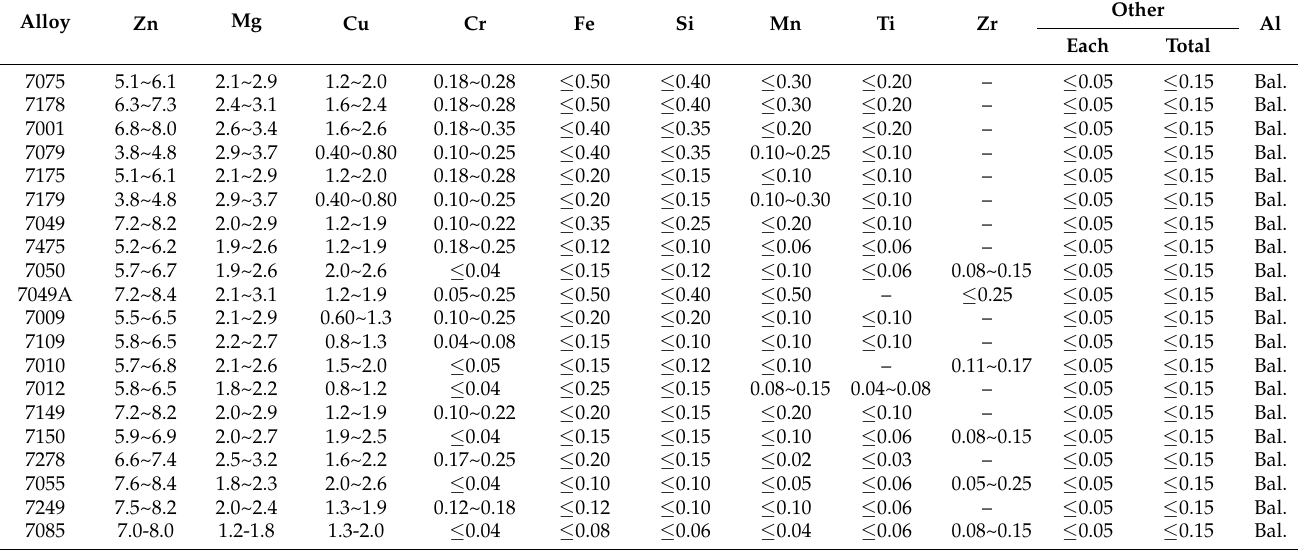
Table 1. Main brands and chemical compositions of Al 7XXX alloys (mass fraction, %)